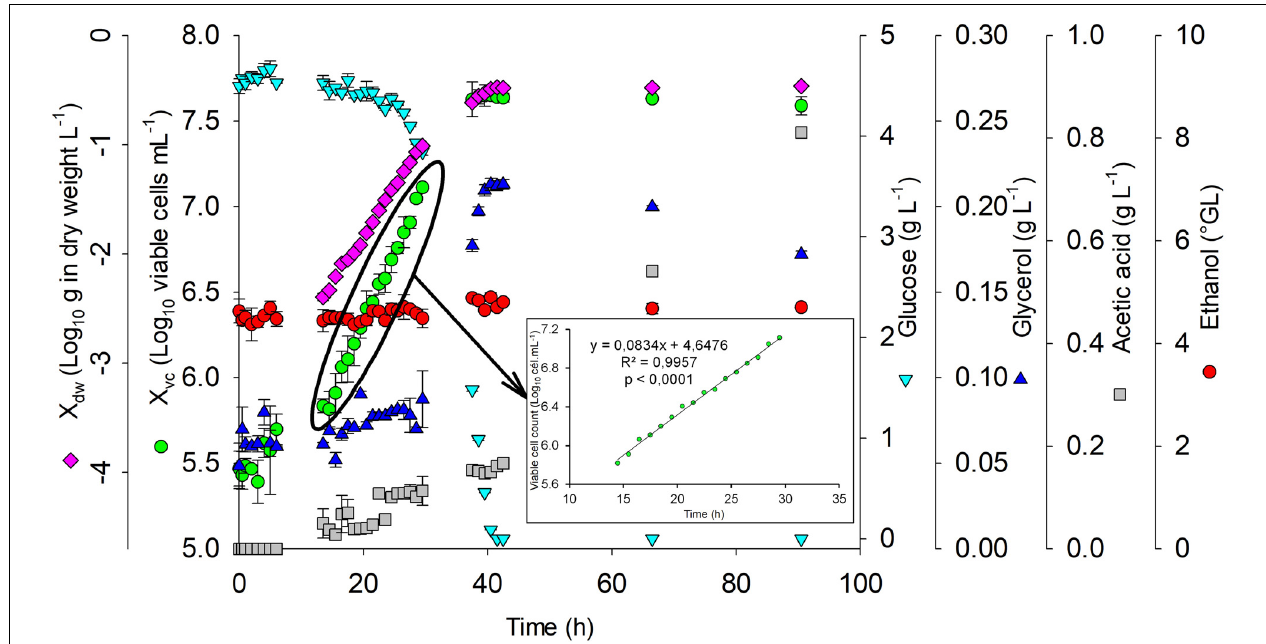
FIGURE 4 | Growth kinetics of S. boulardii . Glucose and ethanol consumption and acetic production for confirmation of the mathematical model carried out with an alcohol content = 5 ◦ GL, pH = 5.5, and temperature = 24 ◦ C. X dw , S. boulardii biomass formation (Log 10 g in dry weight L − 1 ); X vc , viable S. boulardii